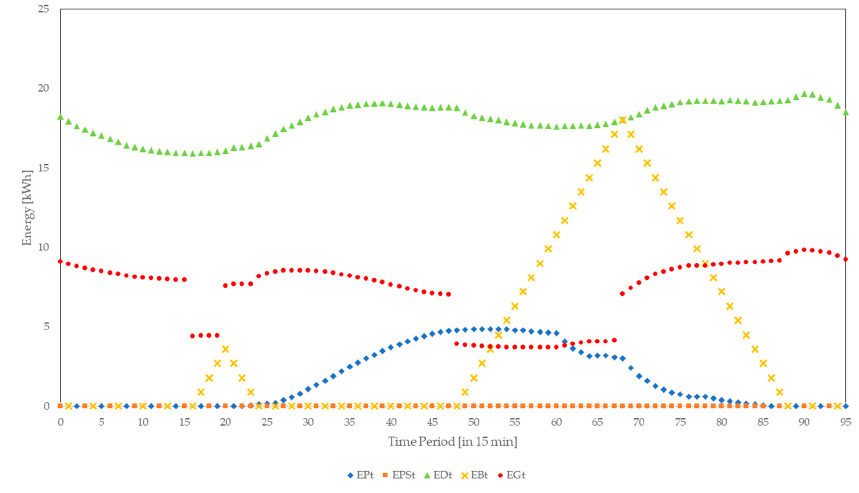
Figure 9. Graphic analysis of the effects of an integrity attack on grid energy demand.